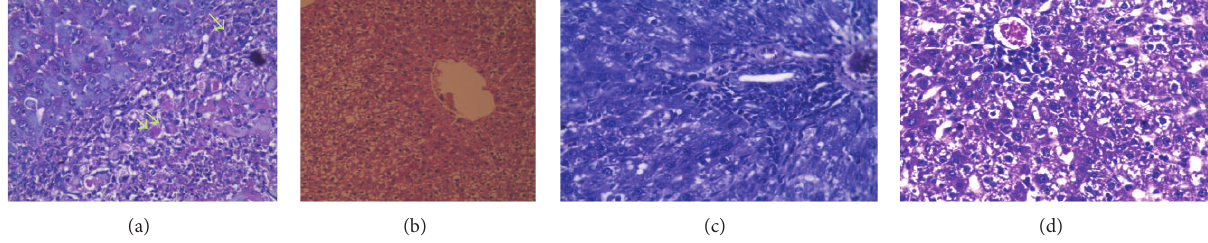
Figure 2: Histopathology of liver sections for groups 7–10: hematoxylin and eosin stain of liver tissue (H&E × 200). (a) Animals treated with GW6471 before fenofibrate and EE & CPZ showed highly eosinophilic cells (one arrow) and necrotic cells (two arrows) with dense mononuclear cellular infiltrations and hypertrophied kupffer cells. (b) Rats treated with GW6471 before fenofibrate and EE & CPZ showed dilated bile duct with no proliferation (H&E × 100). (c) Portal tract in rats treated with GW6471, bezafibrate, EE, and CPZ showed dense mononuclear cellular infiltration and moderate hepatitis changes (H&E × 100). (d) Animals treated with GW6471, gemfibrozil, EE, and CPZ showed dilated engorged central vein and blood sinusoid, mononuclear cellular infiltration, and vacuolar degeneration of liver cells.